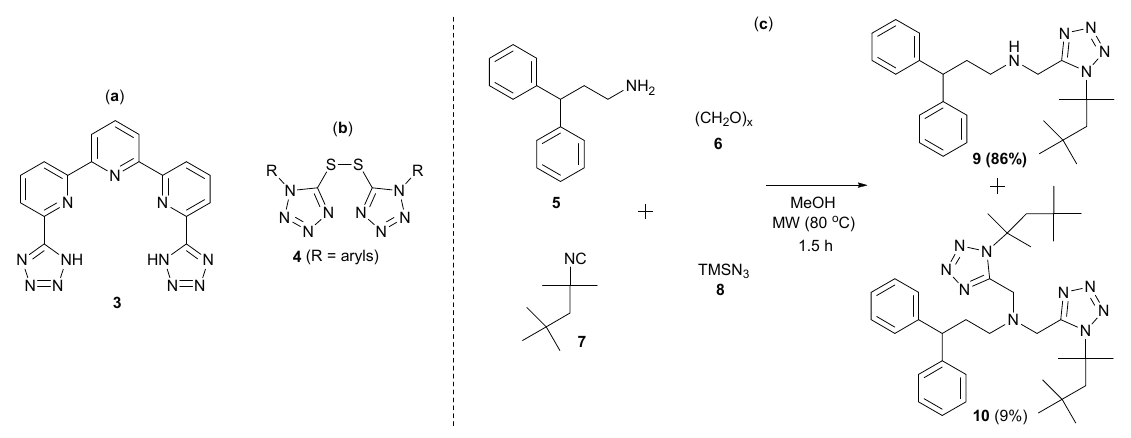
Figure 2. ( a ) Lanthanide cations ligand 3 ; ( b ) bioactive bis -1,5-DS-1 H -T 4 ; ( c ) synthesis of the bis -1,5-DS-1 H -T 10 as a by-product of a Ugi-azide